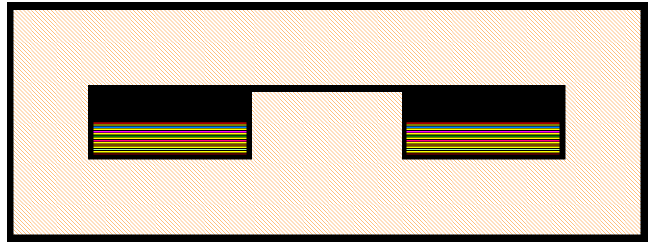
Figure 21. Design II: gapped transformer for 𝑚 = 10 , with a custom core and the same winding Figure 20. Design II: gapped transformer for m = 10, with a custom core and the same winding configuration and scale. configuration and scale. Table 3. Breakdown of losses, volume, and temperature of the two magnetic component designs.